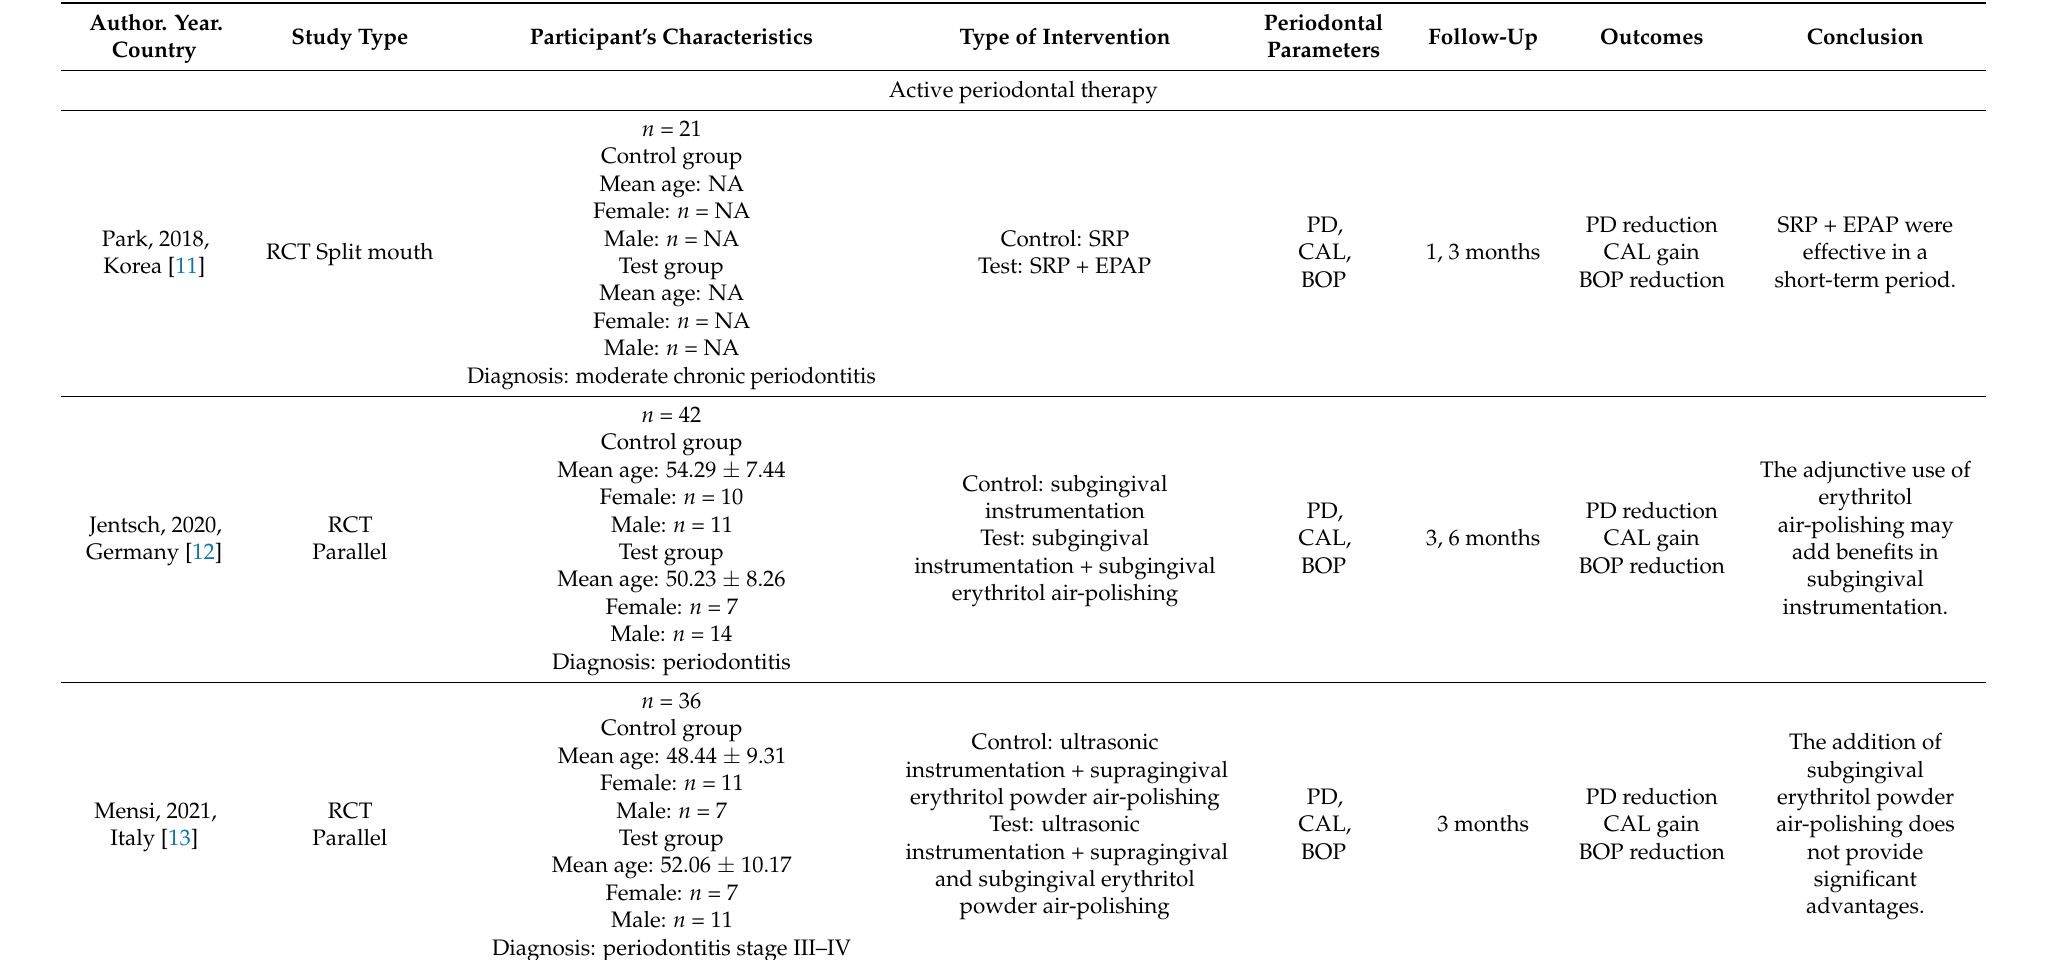
Table 1. Characteristics of the included